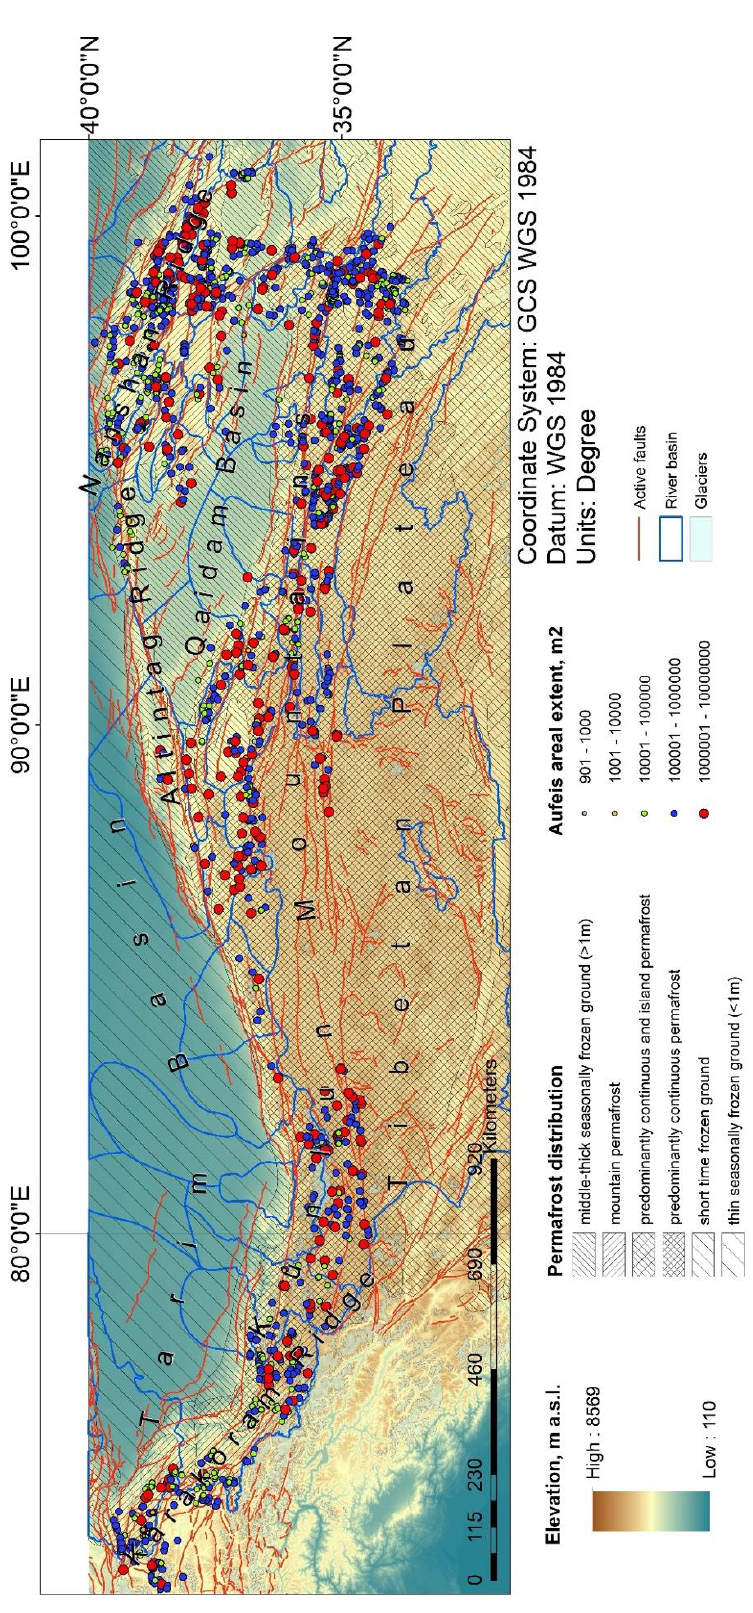
Figure A1. Map of Aufeis distribution within the Kunlun Mountains.